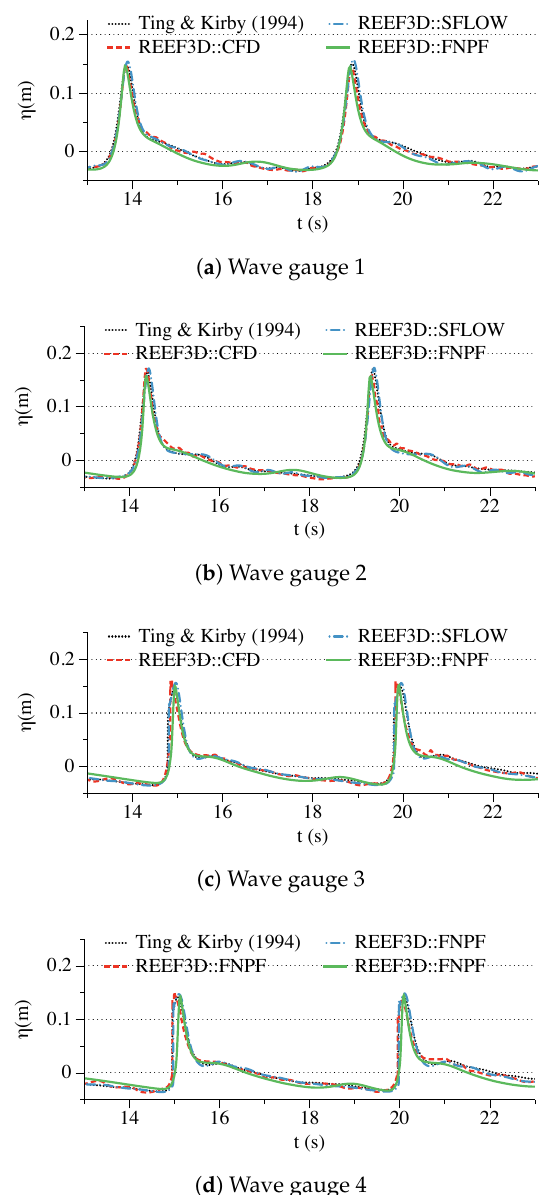
Figure 7. Comparison between the simulated free surface elevation time series from the three REEF3D modules and the experiment measurements at all four wave gauges in the simulations of wave breaking over a mild